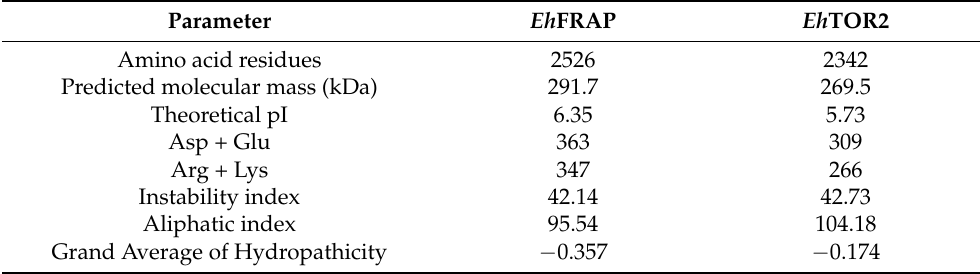
Table 1. Physicochemical properties of the TOR-like amoebic